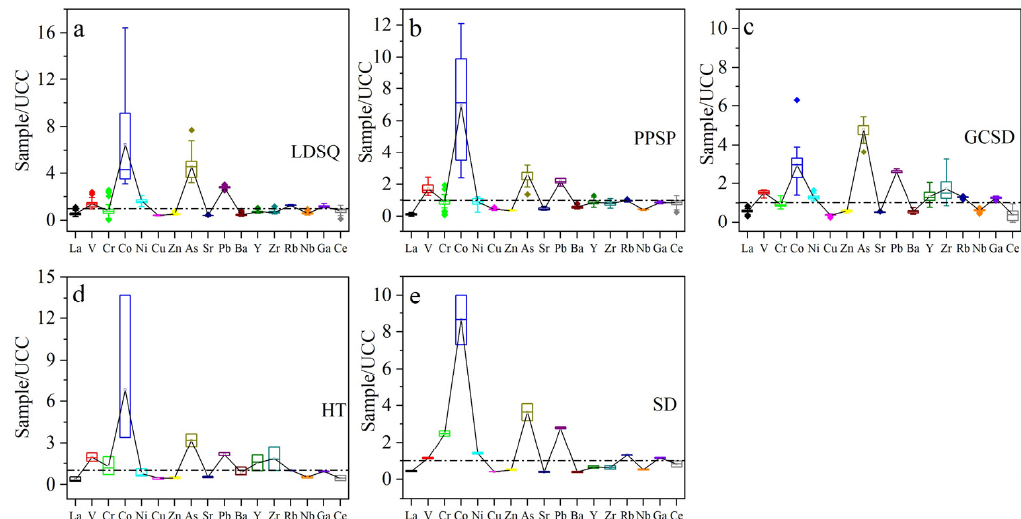
Figure 4. UCC-standardized box line diagram of trace elements for different types of sediments: ( a ) represents mobile dune, ( b ) represents climbing sand sheet, ( c ) represents nebkha, ( d ) represents flood plain, and ( e ) represents lakeshore.